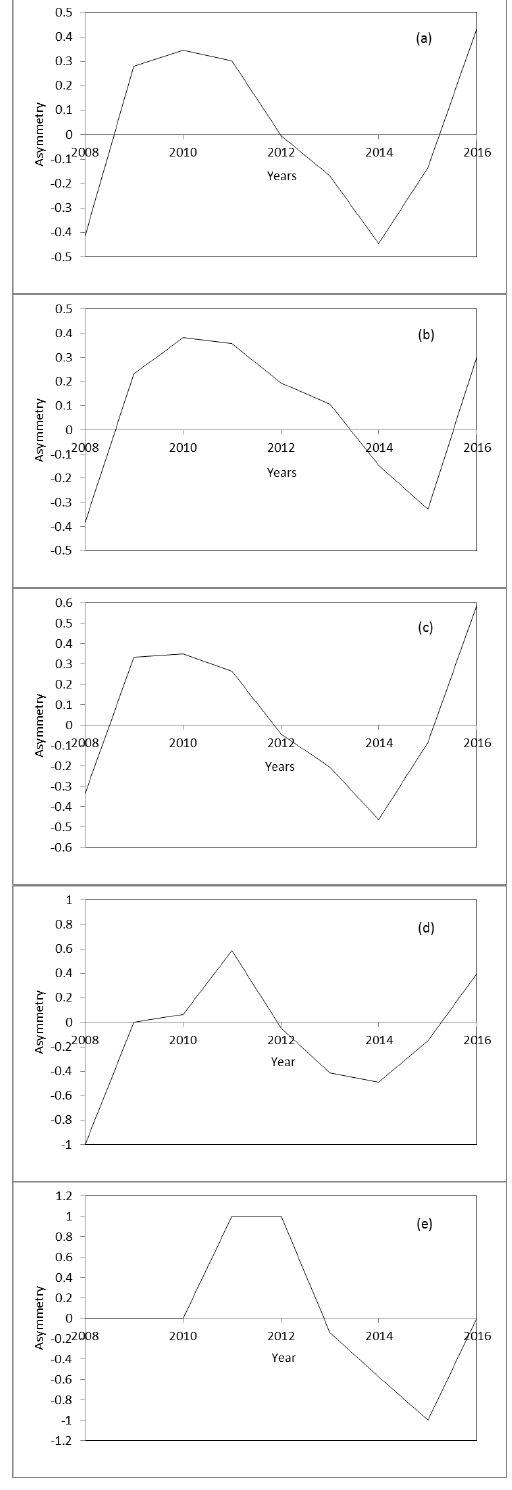
Figure 4. From top to bottom, plots of yearly asymmetry distribution for a) Total, b) B-class, c) C-class, d) M-class and e) X-class SXR